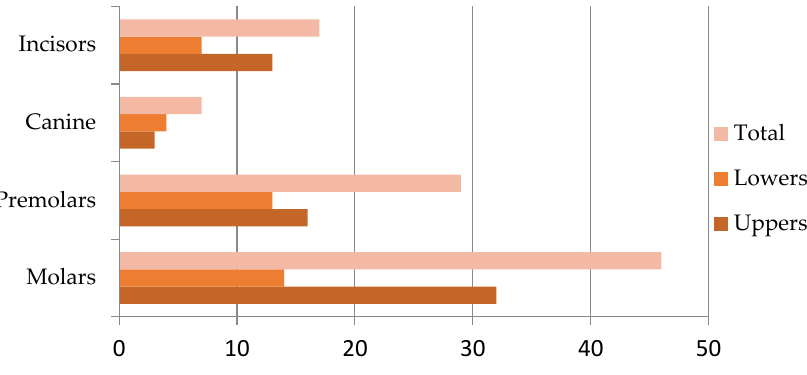
Figure 2. Distribution of treated teeth by tooth type ( n = 99).